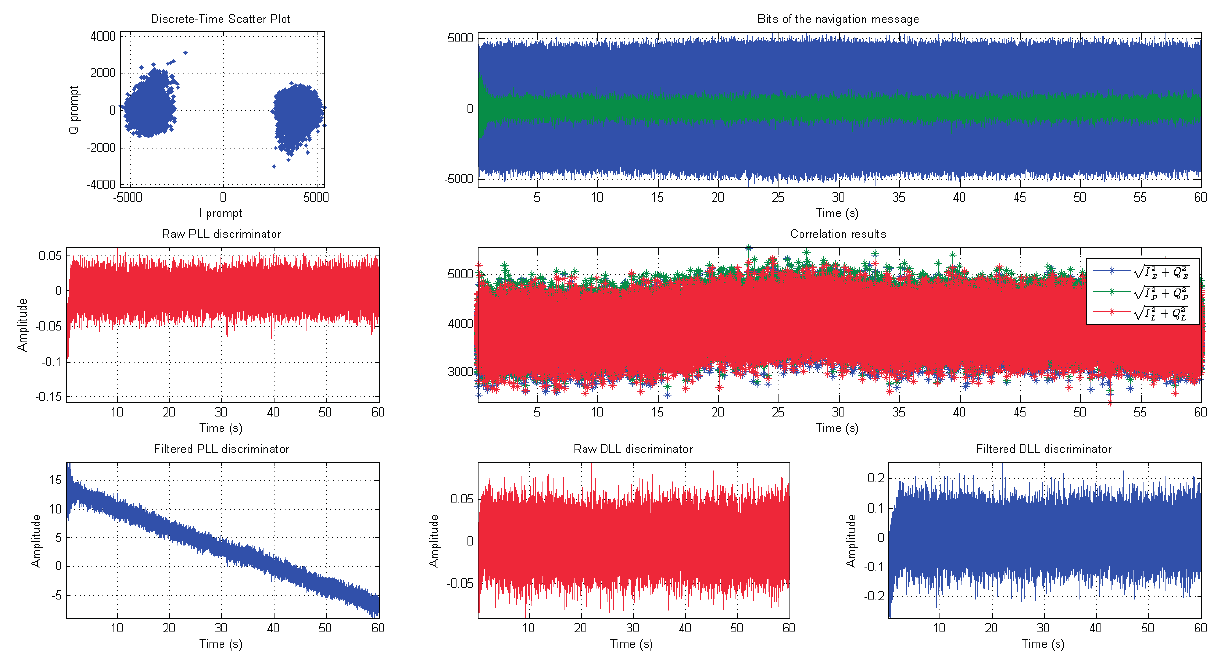
Figure 5. Channel tracking status for PRN